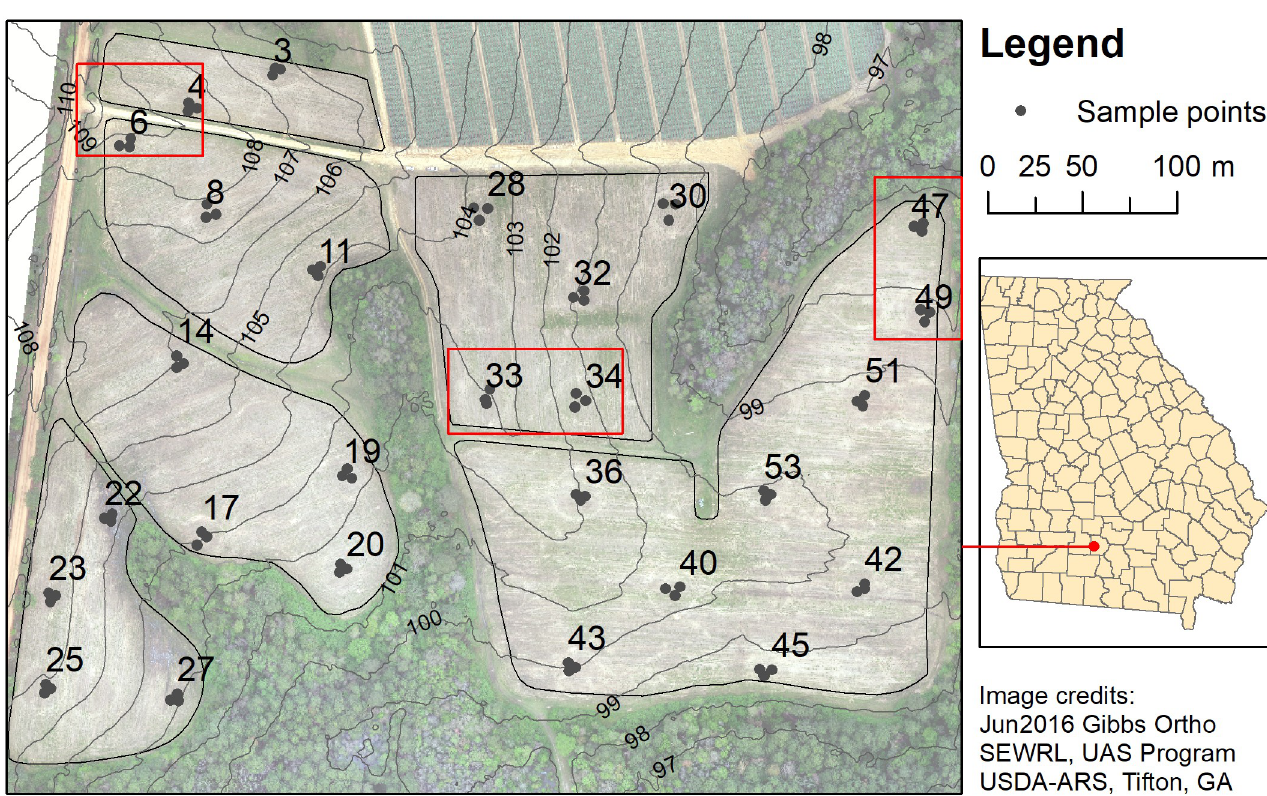
Fig 1. Map showing location and configuration of study area, and sample points. Main points labeled by number. Red boxes indicate locations of main points with detailed data visualized in S7 Fig.